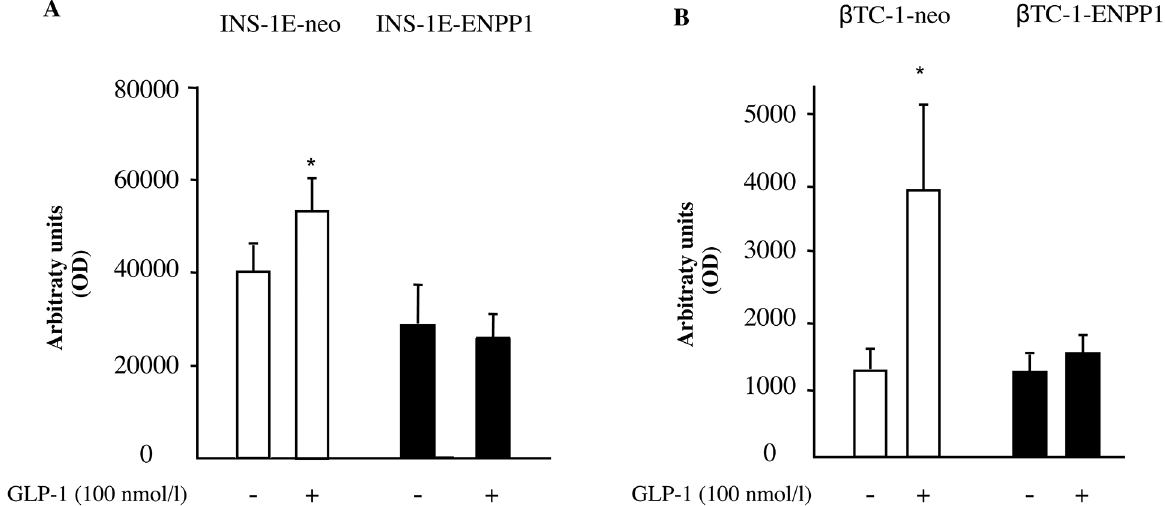
Fig 2. GLP-1 fails to increase cell proliferation in ENPP-1 transfected cells. Proliferation was assessed by BrdU incorporation in INS-1E (panelA) and β TC-1(panelB) cells, either transfectedwith neoor ENPP-1 genevariant. Cellswere starved for 12 hours